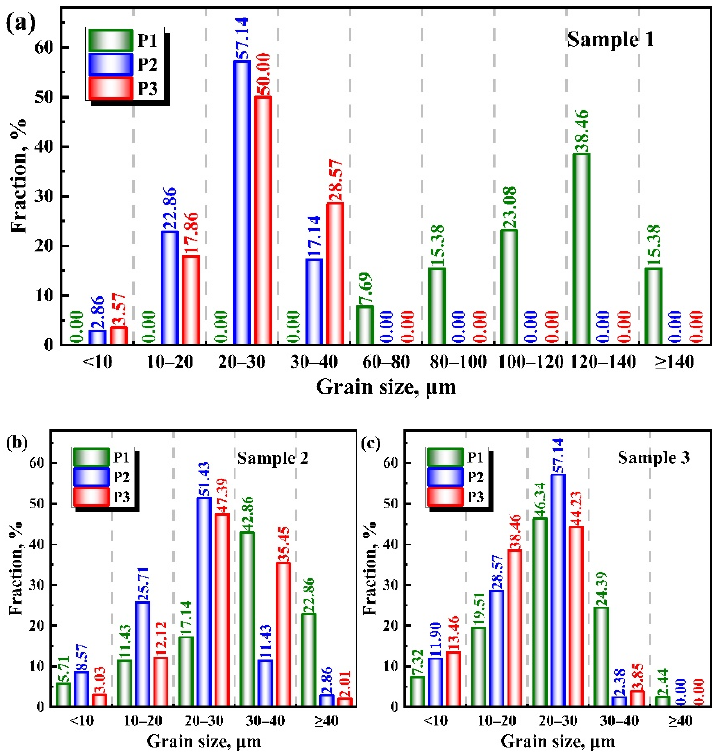
Figure 4. Grain size distribution and statistics of ( a ) Sample 1; ( b ) Sample 2; ( c ) Sample 3 at different tracking points.